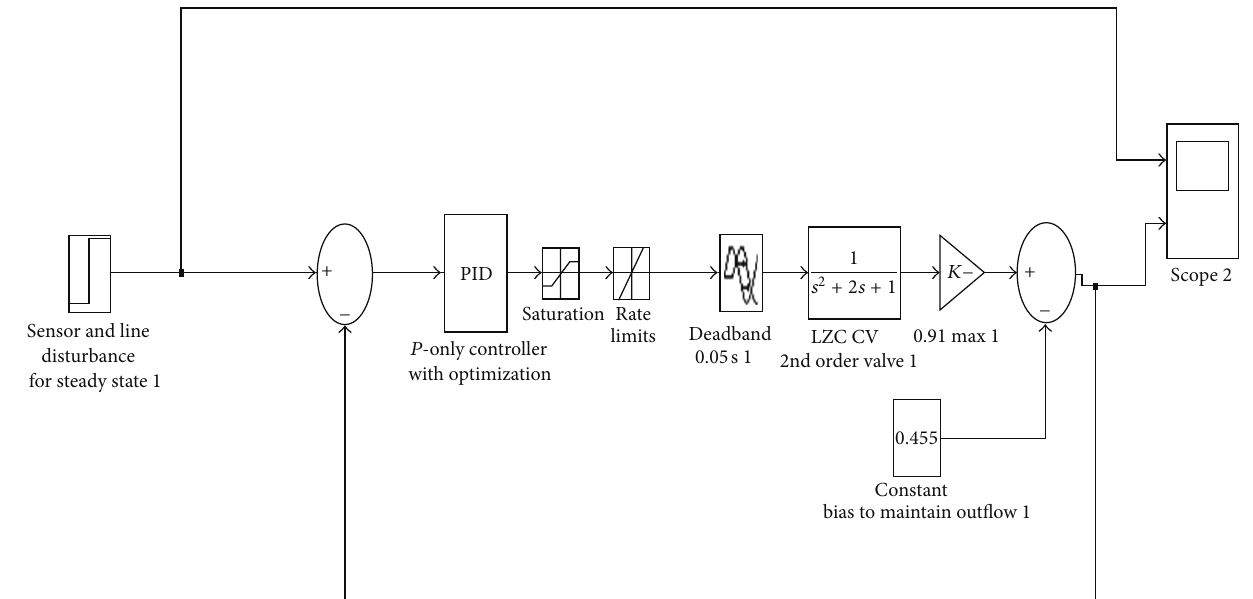
Sensor and line disturbance